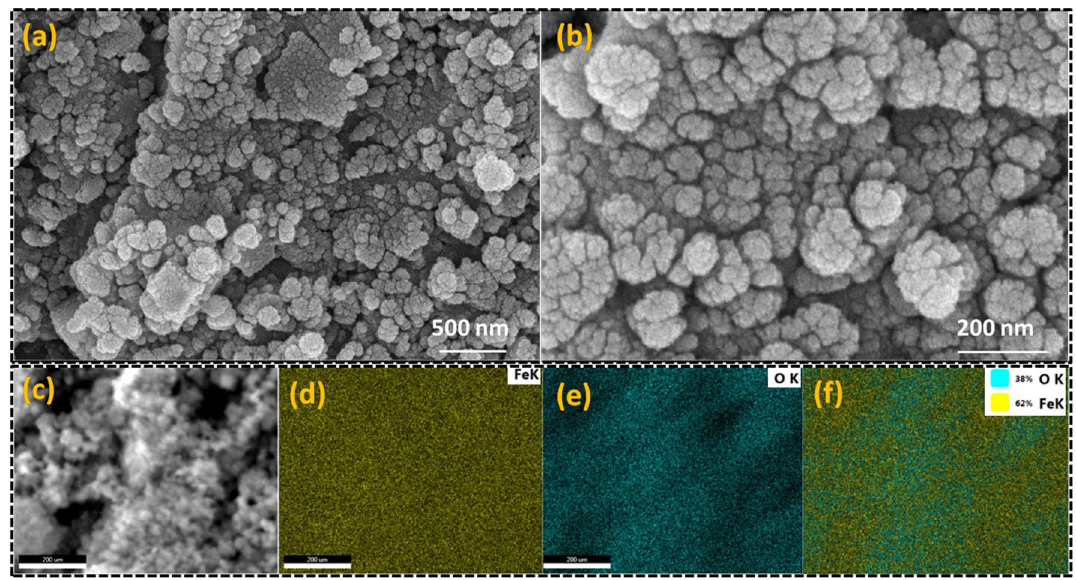
Figure 3. FE-SEM micrograph of Fe 3 O 4 /α-F 2 O 3 nanocomposite at two different magnifications ( a , b ), selected micrograph for the elemental mapping ( c ), elemental mapping for the iron ( d ), oxygen ( e ) and the overlapping of the iron and oxygen element ( f ).